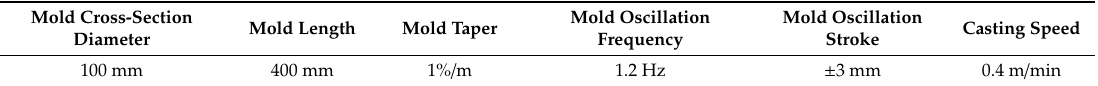
Mold Oscillation Mold Oscillation Casting Speed Frequency Stroke